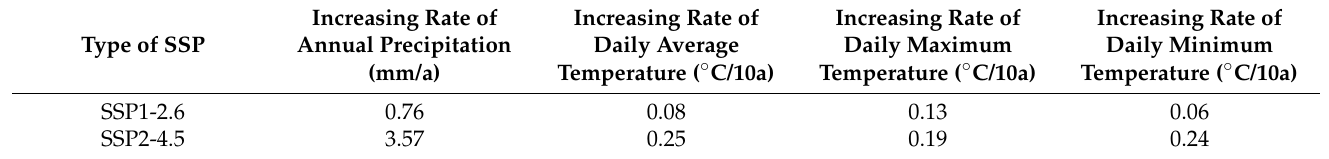
Figure 12. Computed yearly precipitation ( a ); daily average ( b ), maximum ( c ), and minimum ( d ) temperature under SSP1-2.6 and SSP2-4.5. Table 4. Increasing rate of yearly precipitation; daily average, maximum, and minimum